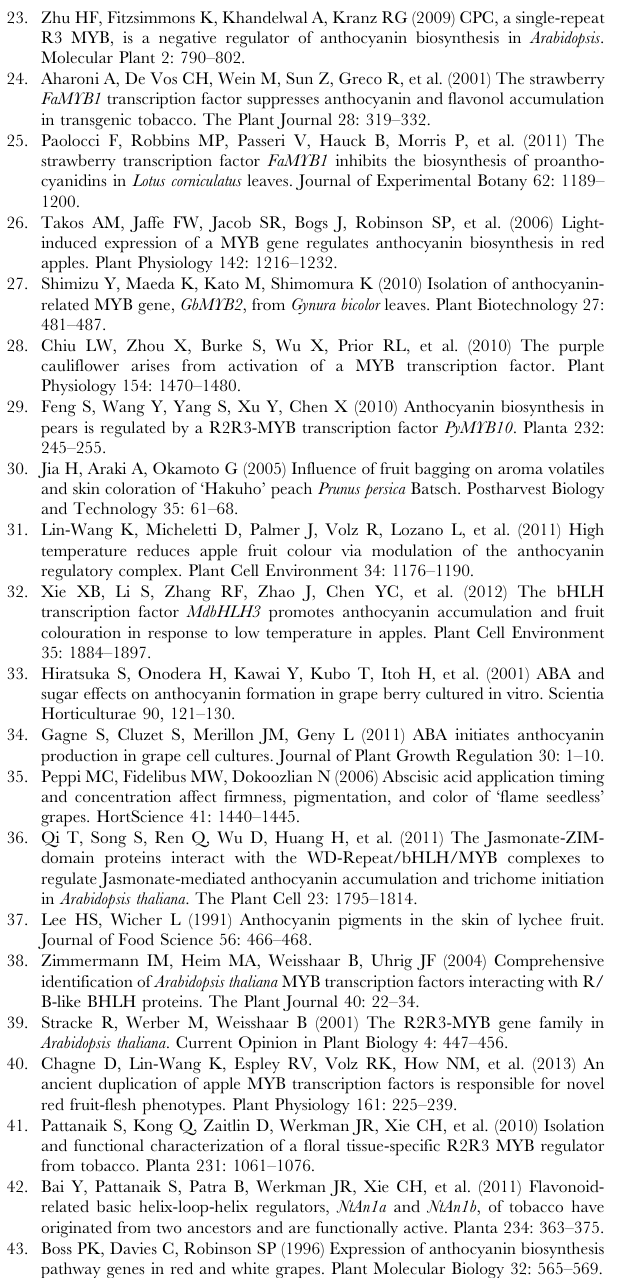
Table S1 Primers for real-time PCR